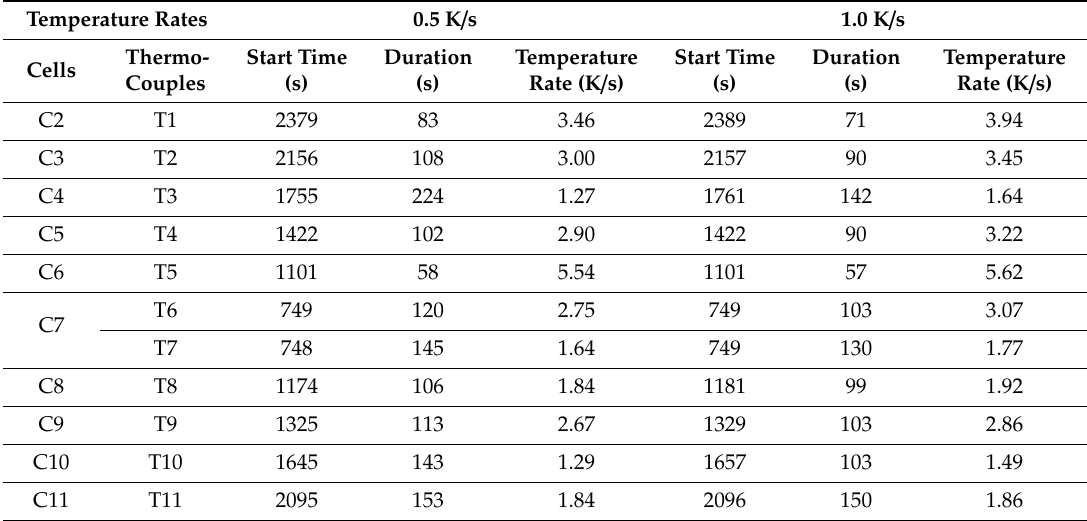
Table 4. Characteristic data of ISC intervals with high temperature rates.